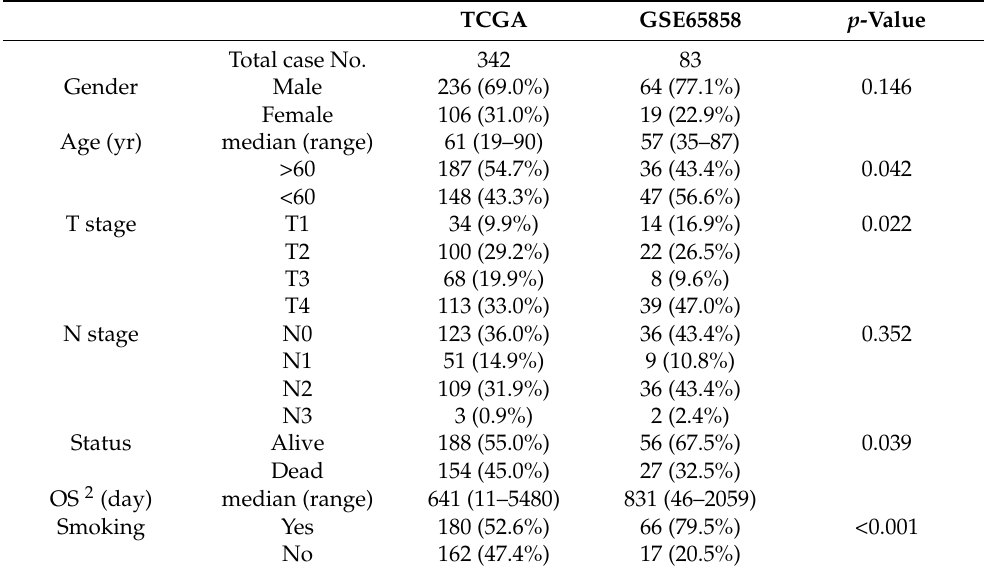
Table 2. Patient demographics of TCGA and GSE65858 cohorts 1